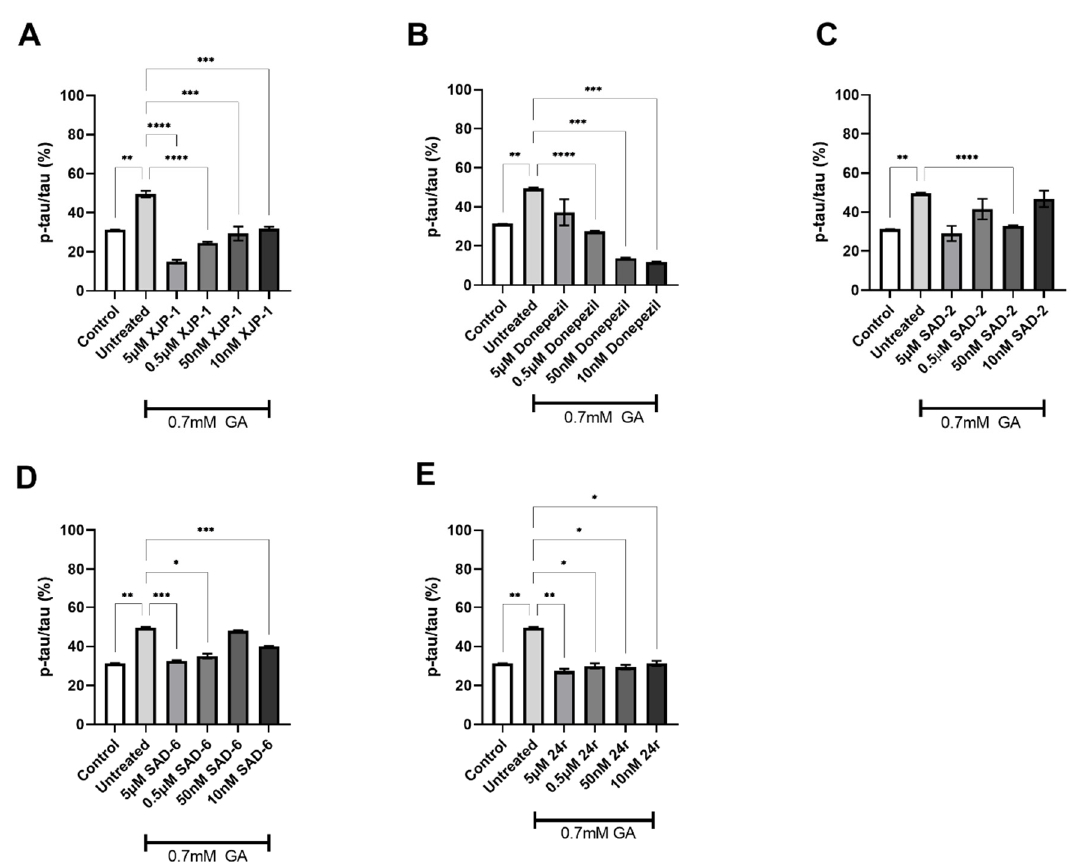
SH-SY5Y-differentiated neurons after XJP-1 treatment. ( B ) Quantification of phosphorylation ratio pTau/tTau on S199 of 0.7 mM GA-treated SH-SY5Y-differentiated neurons after Donepezil treatment. ( C ) Quantification of phosphorylation ratio pTau/tTau on S199 of 0.7 mM GA-treated SH-SY5Y- differentiated neurons after SAD-2 treatment. ( D ) Quantification of phosphorylation ratio pTau/tTau on S199 of 0.7 mM GA-treated SH-SY5Y-differentiated neurons after SAD-6 treatment. ( E ) Quantifi- cation of phosphorylation ratio pTau/tTau on S199 of 0.7 mM GA-treated SH-SY5Y-differentiated neurons after 24r treatment. Kruskal–Wallis test followed by Dunn’s post-hoc was used to compare the differences between different groups. Data are expressed as mean ± SEM, n = 3 with at least 5 repetitions per experiment,* p < 0.05; *** p < 0.001, **** p < 0.0001. To further assess the efficacy of the novel compounds in preventing Tau abnormal phosphorylation, another residue, S396, was examined. In neurons treated with 0.7 mM all concentrations tested (Figure 5A–E).